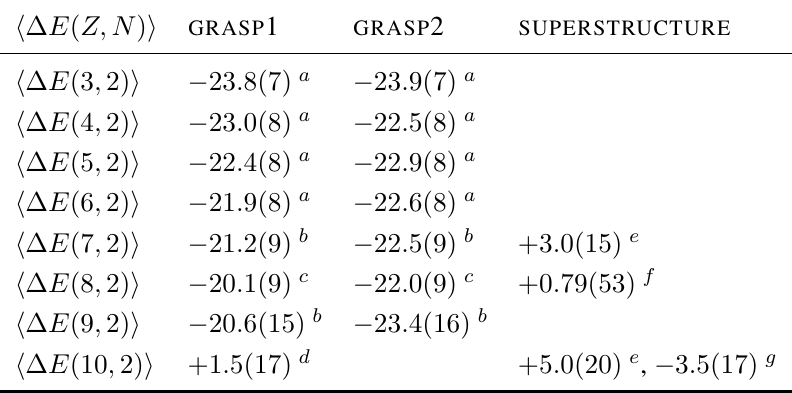
Table 5. Average differences ( 10 3 cm − 1 ) between the spectroscopic level energies of the NIST database (v5.1) and those computed with GRASP ( a [124], b [123], c [122], d [125]) and SUPERSTRUCTURE ( e [128], f [126], g [127]). GRASP 1: excludes Breit and QED effects. GRASP 2: includes Breit and QED effects. The quantity in brackets gives the standard